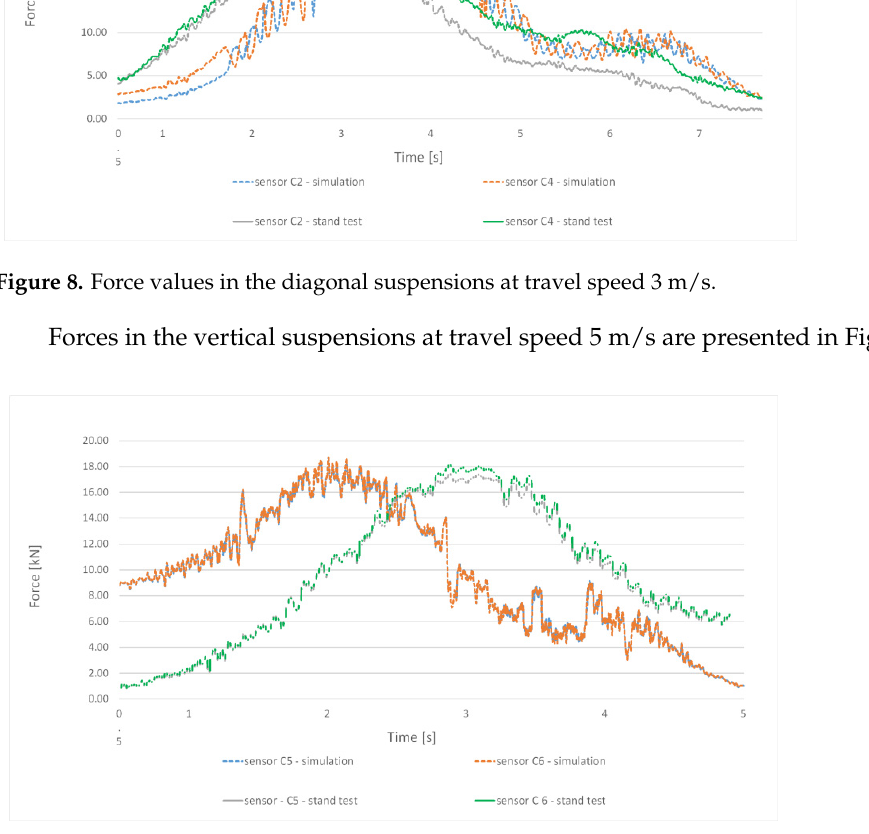
Figure 9. Force values in the vertical suspensions at travel speed 5 m/s. Forces in the diagonal suspensions at travel speed 5 m/s are presented in Figure 10.